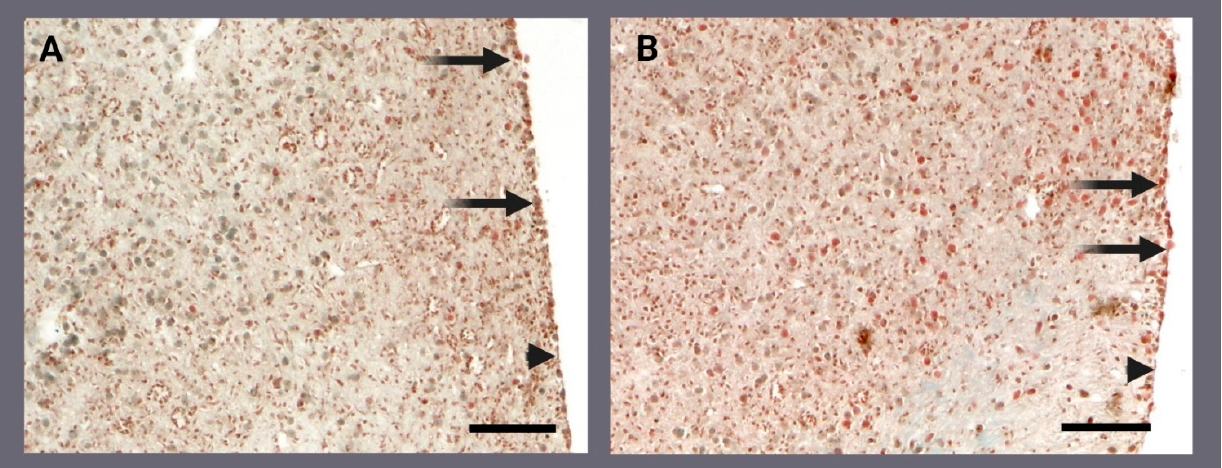
Figure 2. Histological sections showing the regenerating edges of Chondrosia reniformis fragments 24 h after being cut. The ( A ) control (810 nm-0 W photo-biomodulation [PBM]) and ( B ) irradiated (810 nm-1 W PBM) fragments were stained with Masson’s trichrome. Some spherulous cells (arrows) and exopinacocyte-like cells (arrowheads) are visible on the regenerating edge. The scale bars are 50 µm .